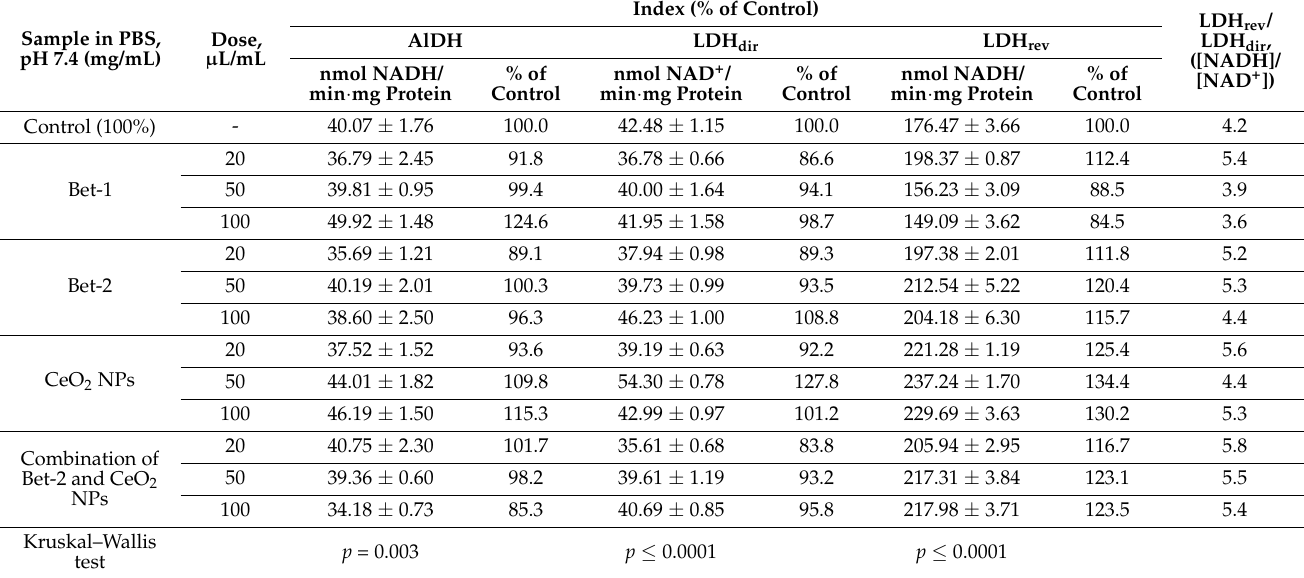
Table 4. The specific activity of aldehyde dehydrogenase and lactate dehydrogenase in direct and reverse reactions under the action of the studied compounds (% of control), n = 3, p < 0.001.